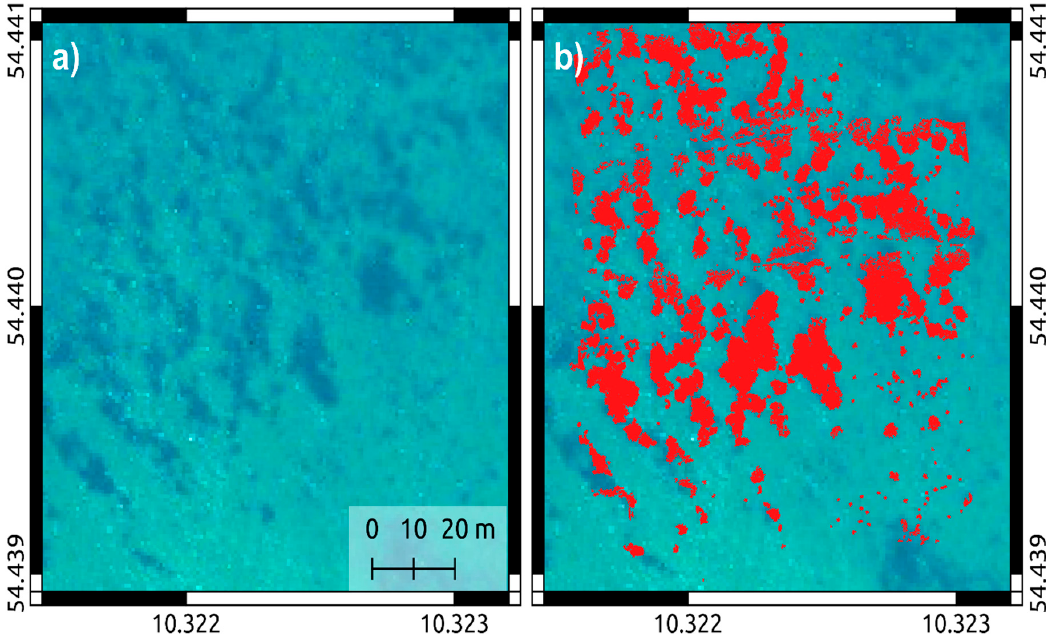
Figure 5. Aerial view of SA2: ( a ) plain for comparision and ( b ) with superimposed RF-classified SAV returns, showing a high agreement with the dark patches in the photograph, caused by SAV, and the results of the PCL classification.